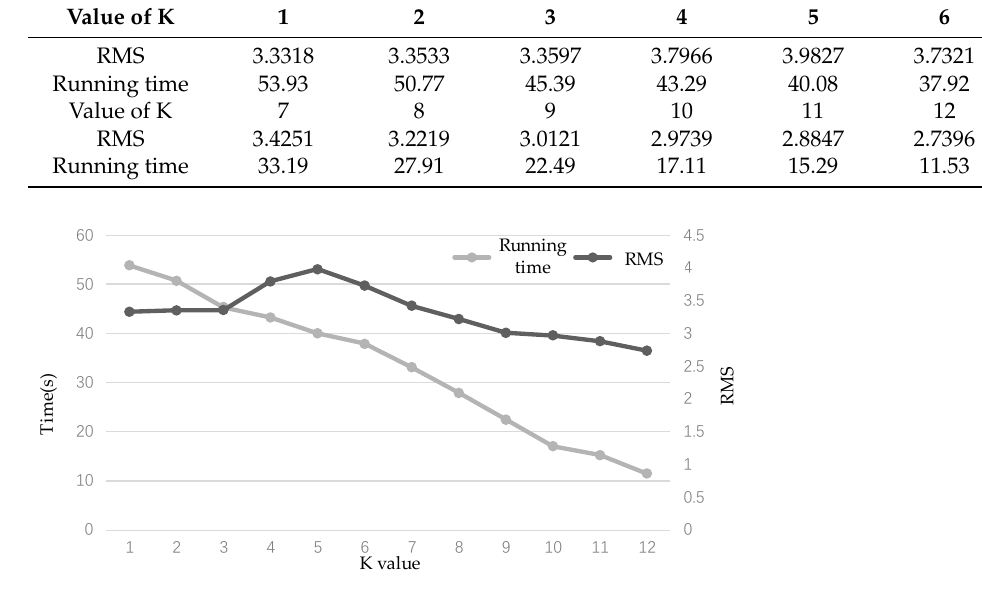
Figure 9. The depth estimation method based on geometric constraints evaluation index line graphs.